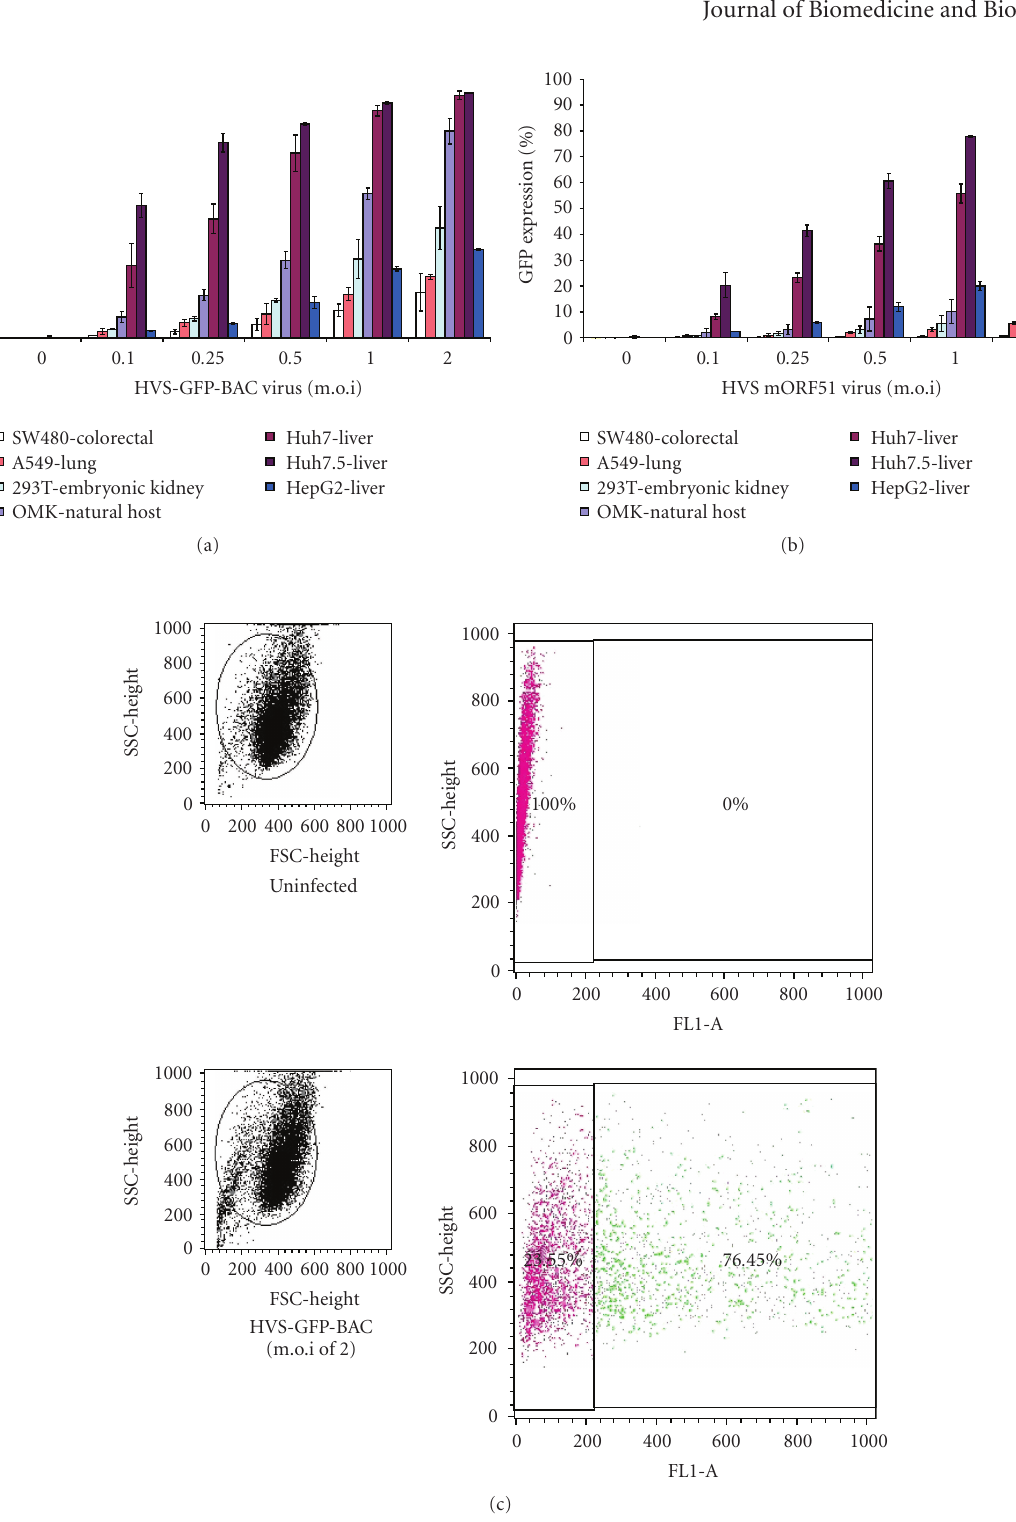
Figure 7: Comparison of wild-type and mutant virus entry measured by GFP expression. A range of human cancer cell lines were infected with increasing amounts of HVS-GFP-BAC (a), and HVS mORF51 (b). Owl monkey kidney (OMK) cells (permissive to the virus) were also used as a control, representative dot plots of which are shown in (c). 48 h after infection, GFP expression was measured by flow cytometry using a Becton Dickinson FacsCalibur ( n = 2). Mutation of the ORF51 glycoprotein inhibits virus entry in OMK cells and several of the cancer cell lines. However, the HCC-derived cell lines are still able to be e ffi ciently infected, suggesting that the SSTR binding region in the mutated protein facilitates viral attachement in these SSTR-expressing